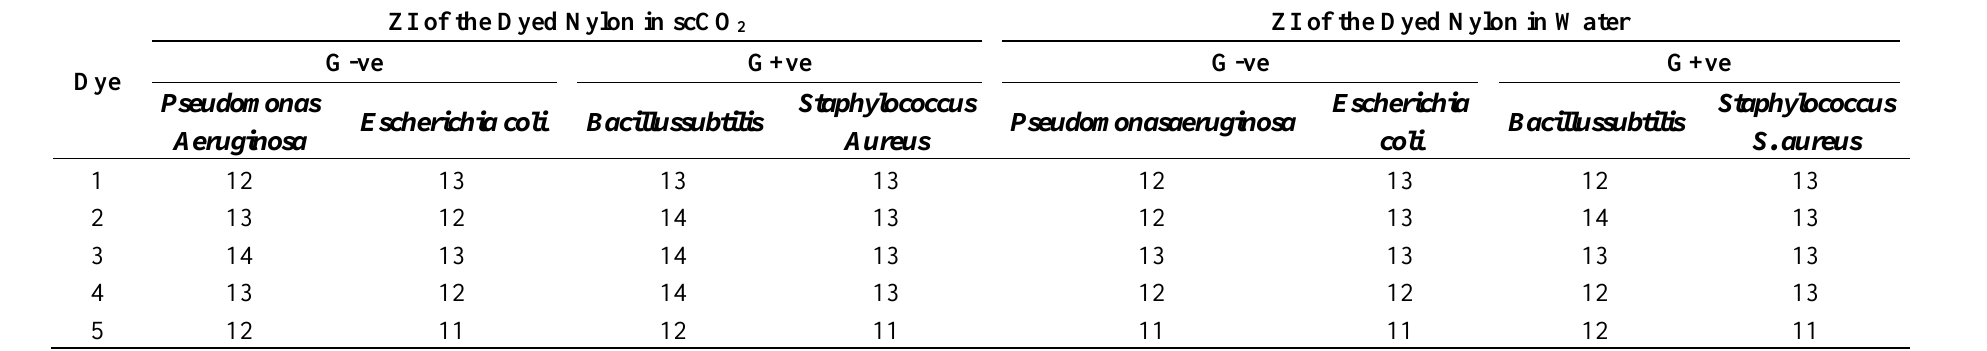
Table 2. Antibacterial activity of dyed